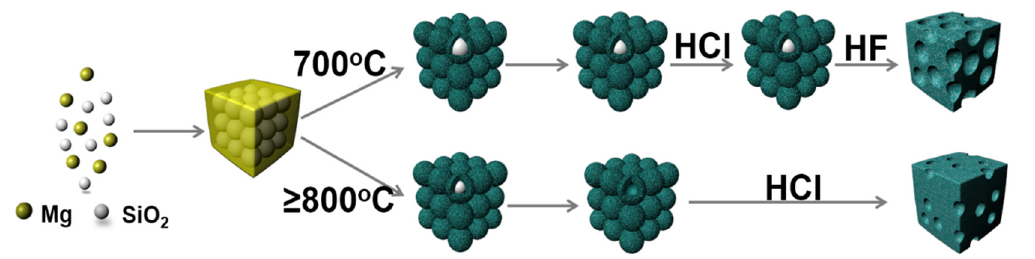
Scheme 1. Schematic figure of the mechanism for the formation of 3D hierarchical macro- /mesoporous silicon after HCl washing at different magnesiothermic reduction temperatures.